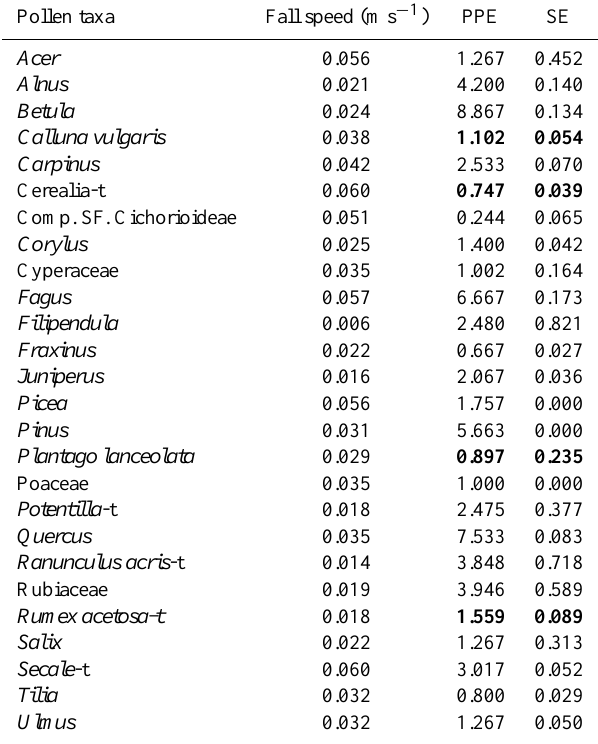
Table 2. Fall speed of pollen, relative pollen productivity estimates (PPE) and associated standard error estimates (SE) for 26 taxa ob- tained for southern Sweden (Sugita et al., 1999; Brostr¨om et al., 2004) and Denmark (numbers in bold; Nielsen et al., 2004) used in the REVEALS model